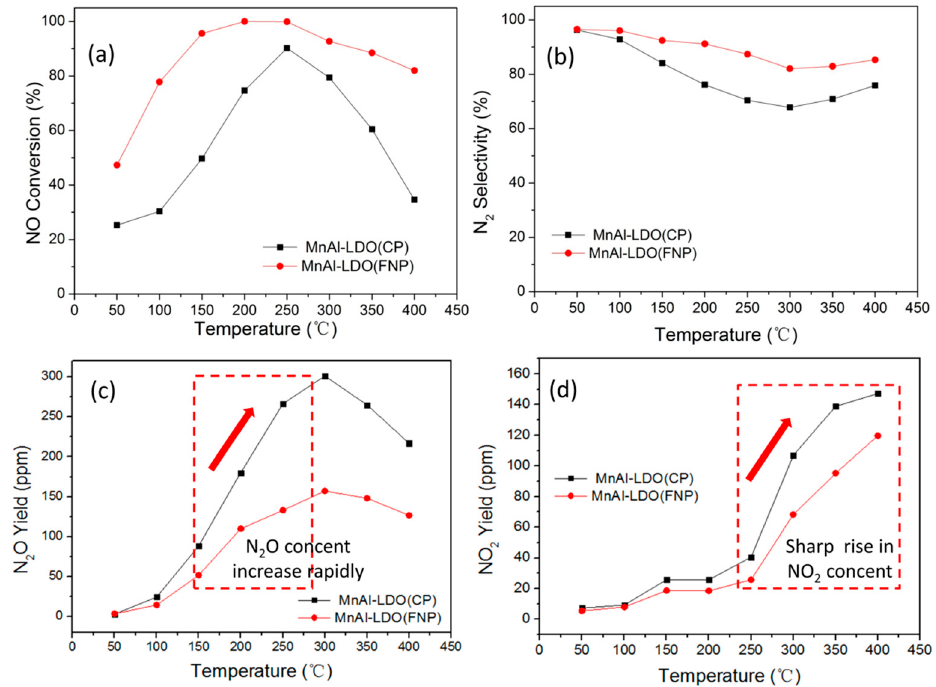
Figure 5. ( a ) NO conversion; ( b ) N 2 selectivity; ( c ) N 2 O yield and ( d ) NO 2 yield of MnAl-LDO (CP)